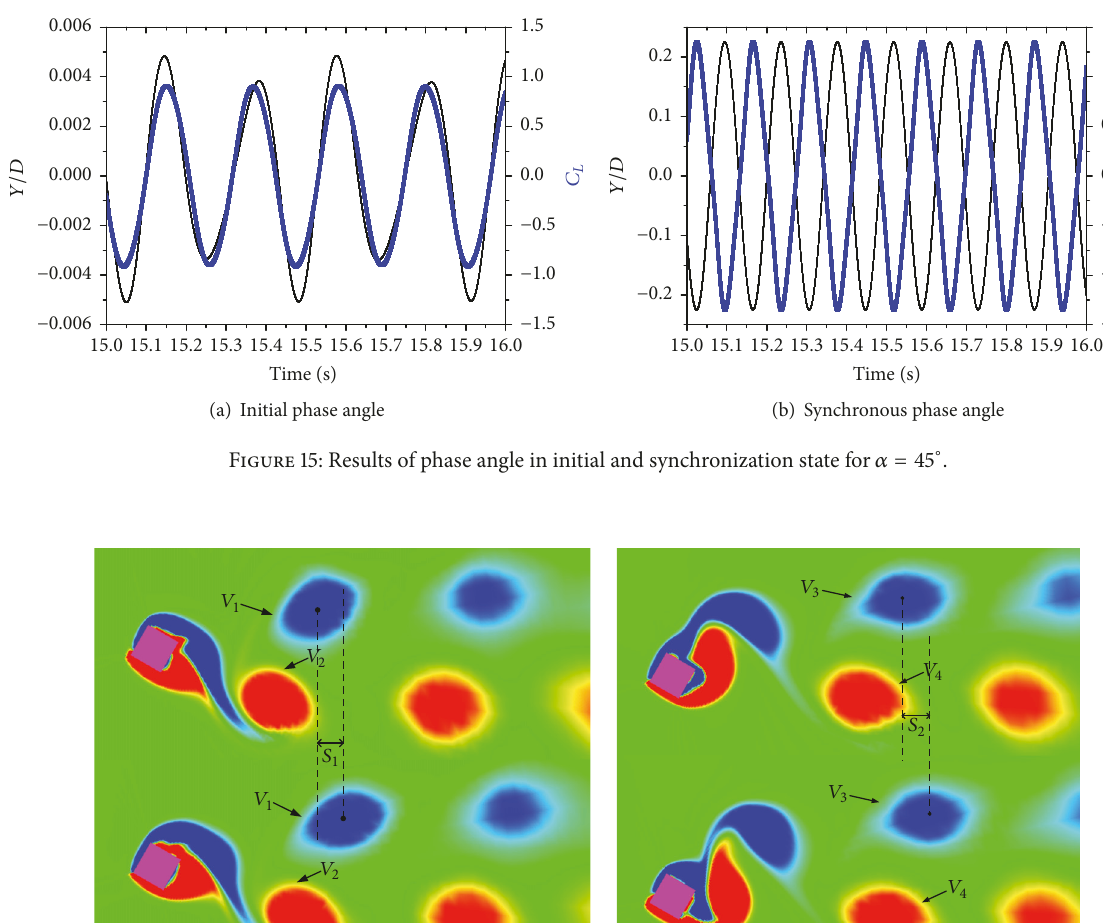
the corresponding value is 4.5 × 10 −5 W. Therefore, square column VIVPEH under attack angle 𝛼 = 45 ∘ is an ideal PEH, because of its higher voltage output value and larger working